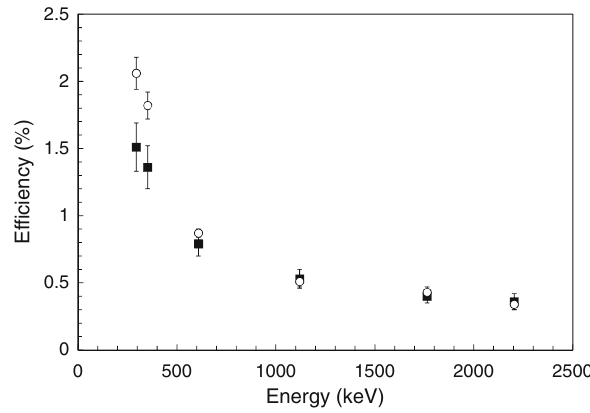
Fig. 9 Efficiency of our HPGe detector to a 222 Rn source filling the inner volume of its shielding. The squares were estimated profiting a 222 Rn efficiency relative measurement and the circles using Geant4 with an approximate geometry. In both cases the estimated values were normalized to the measured efficiency at 1460.8 keV